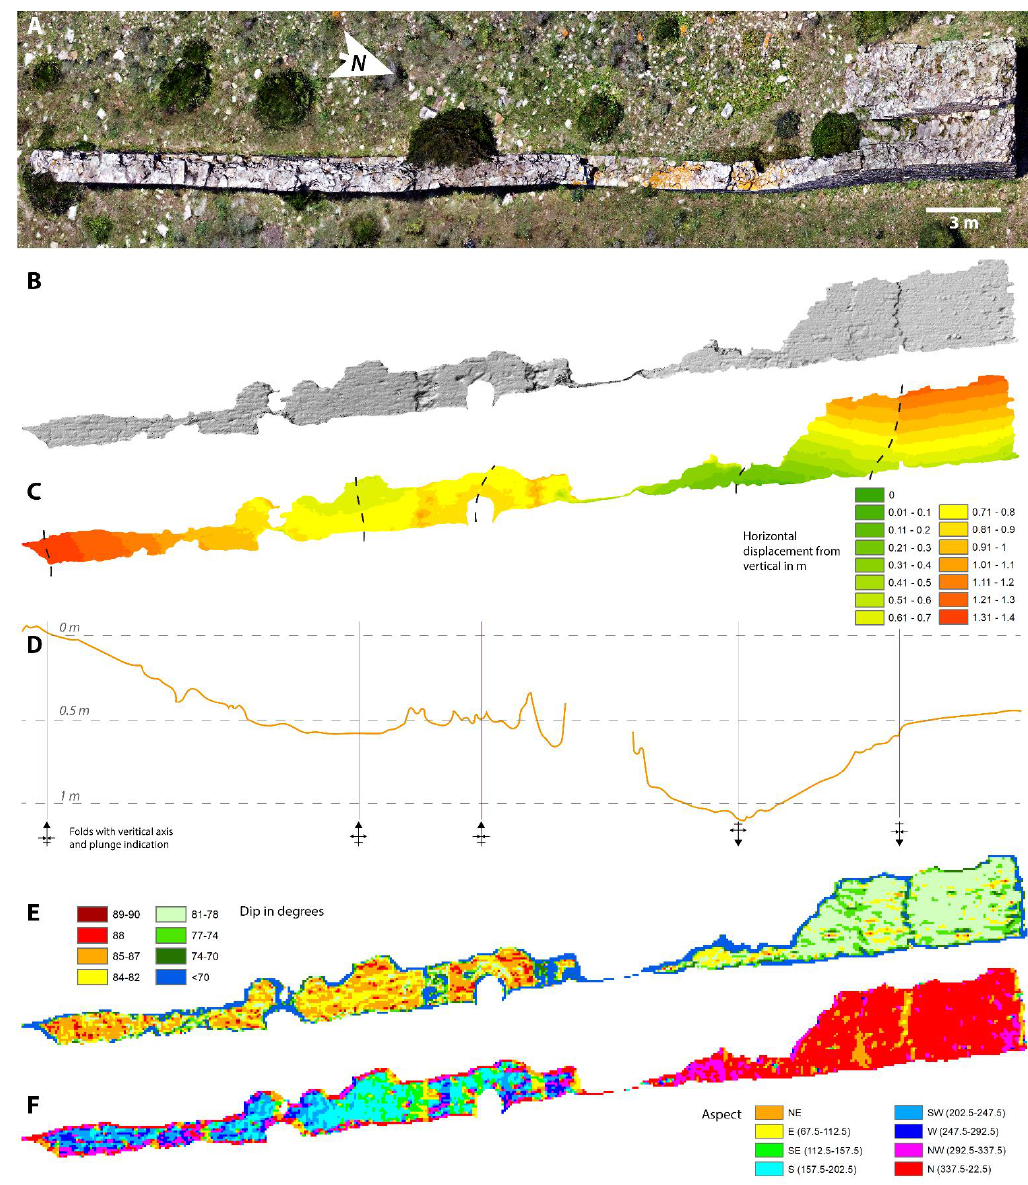
Figure 6. ( A ) Orthophoto of the northern bastion of the city walls obtained in this work. Note the strong deformation in the form of folds with a vertical axis and the relevant tilting of the most northeastern part of the east side of the city wall. ( B ) Hillshade model of the east side of the city wall and bastion. ( C ) Hypsometric distribution of the horizontal displacement from the vertical in cm on the E side of the city wall; note the different sectors all constrained by the deformation caused by the earthquake. Those sectors correspond with fractures and overall folding. ( D ) Vertically exaggerated topographic profile along the mid part of the remains of the studied wall. The profile shows up to five folds developed in the city wall. ( E ) Slope distribution (dip in degrees) along the studied side of the city wall. Note how the city wall is more tilted towards the NE. ( F ) Aspect model of the east panel of the wall coherent with the deformation depicted in D and F. Note that models B and C were obtained from a DEM with 1 mm of pixel resolution and models E and F with a 10 cm DEM pixel